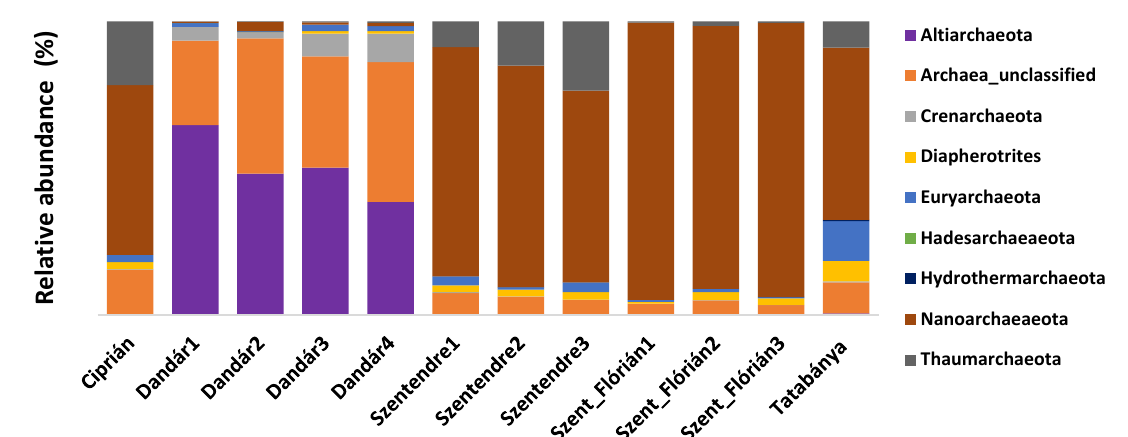
Figure 2. Distribution of the most abundant archaeal phyla based on 16S rRNA gene amplicon sequencing in the water samples.